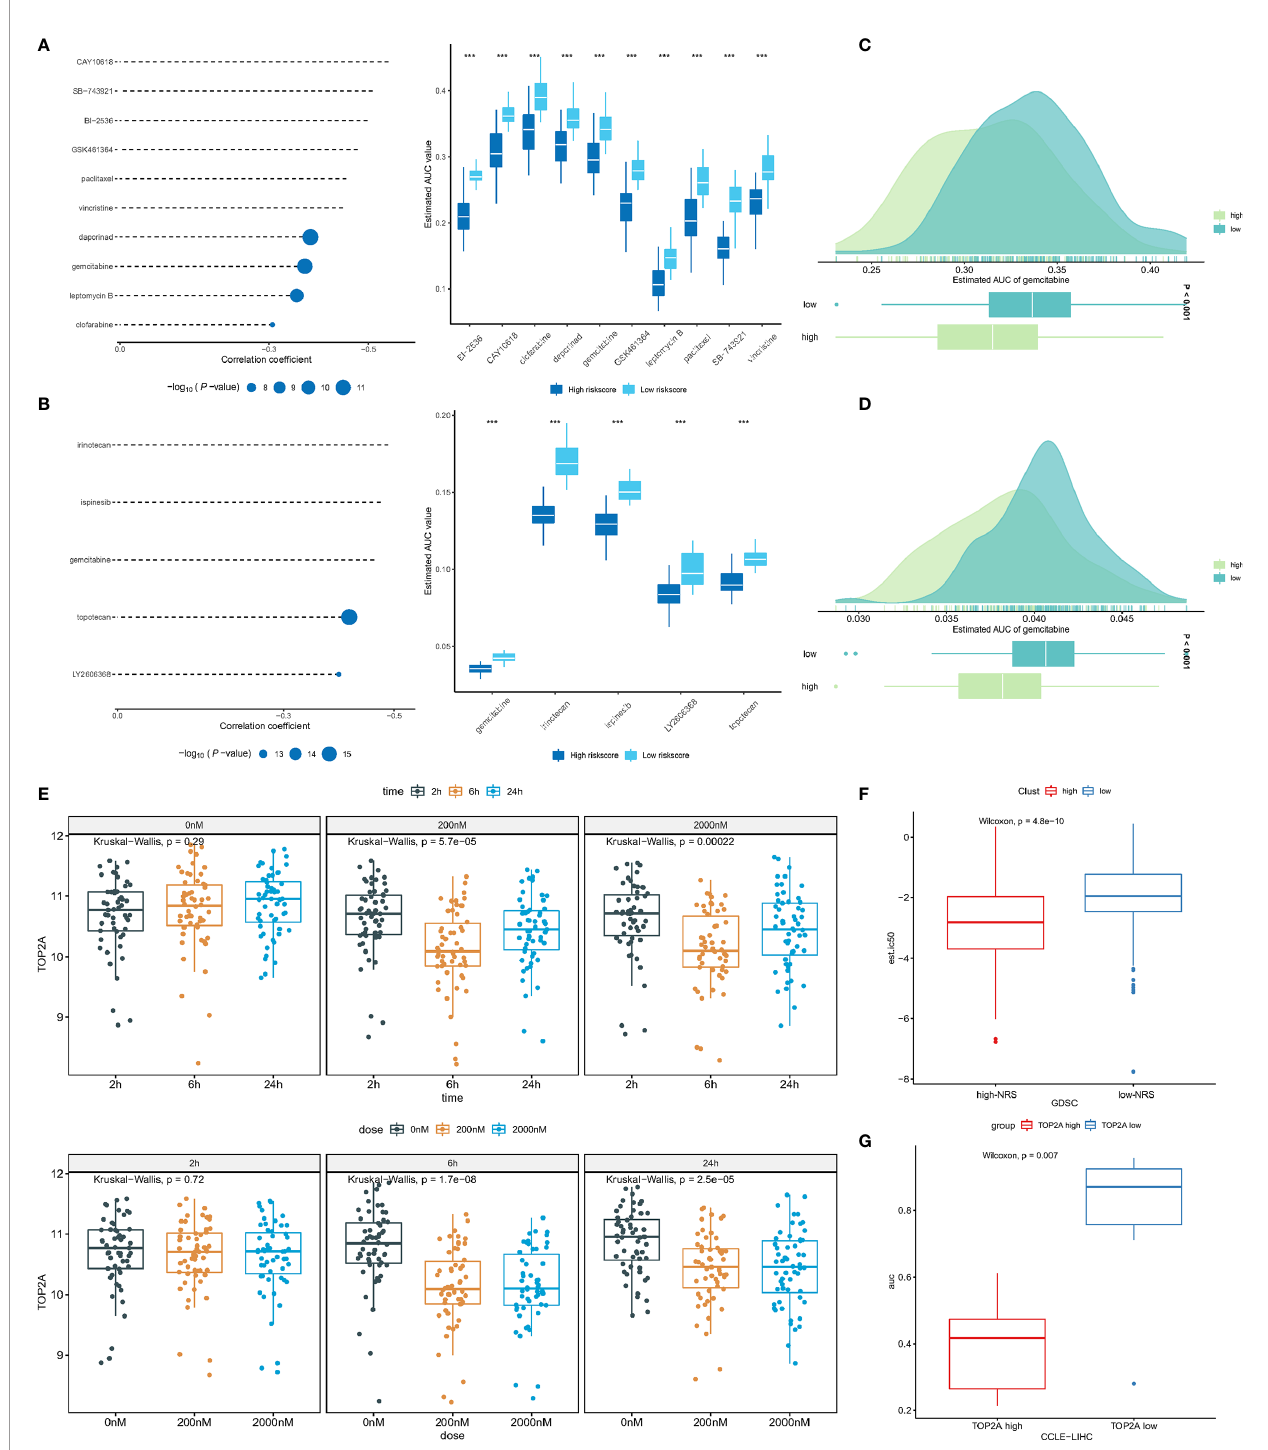
FIGURE 7 | (A) Correlation and difference of CTRP-derived compounds; (B) Correlation and difference of PRISM-derived compounds; (C) AUC of gemcitabine (CTRP); (D) AUC of gemcitabine (PRISM); (E) The expression of TOP2A in different gemcitabine concentration and treatment time; (F) The difference of predicted IC50 between low- and high-NRS groups; (G) The difference of AUC between expression of TOP2A high and TOP2A low groups.